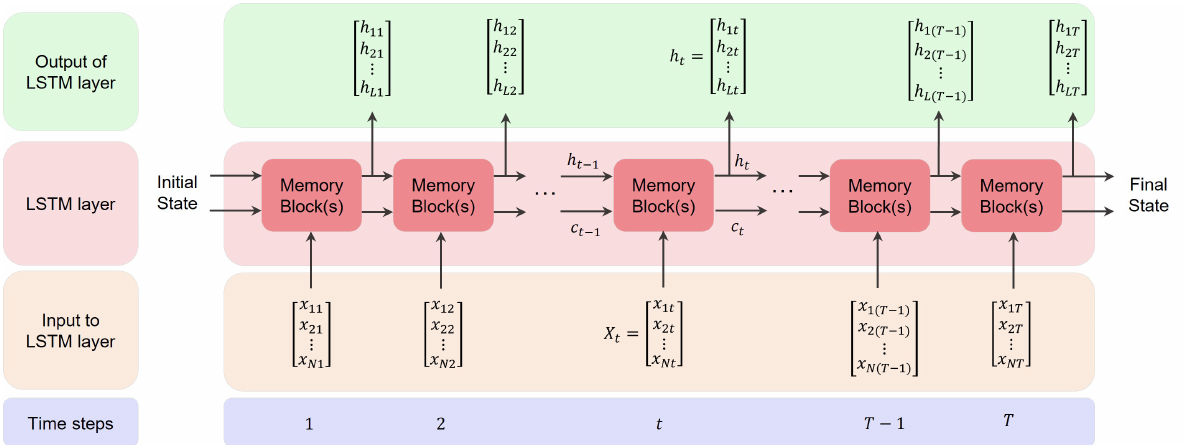
Figure 3. Flow of information in a bidirectional LSTM layer during different time steps with forward and backward states, where X , Y , (cid:126) h , and (cid:126) h refer to the input, output, forward state, and backward state in the LSTM layer, respectively.